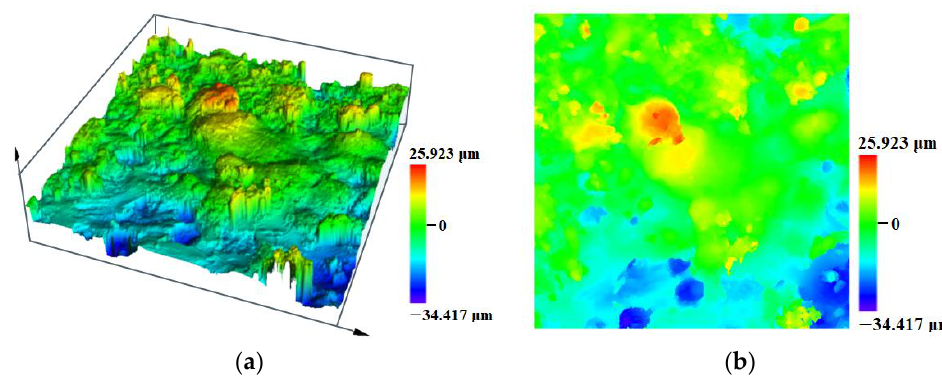
Figure 11. Laser microscope scanning results. ( a ) 3D scanned image, ( b ) 2D contour chart.